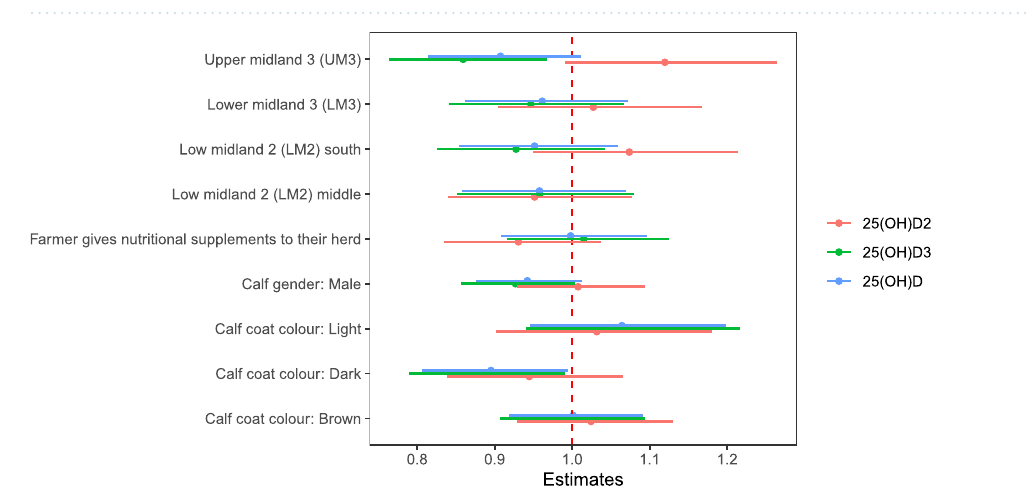
Figure 4. Median serum 25(OH)D concentration (nmol/l) in each agro-ecological zone and sublocation. Figures a-c represent: (a) 25(OH)D2; (b) 25(OH)D3 and (c) 25(OH)D. Refer to Fig. 4 for the names of the agro- ecological zones and sublocations.